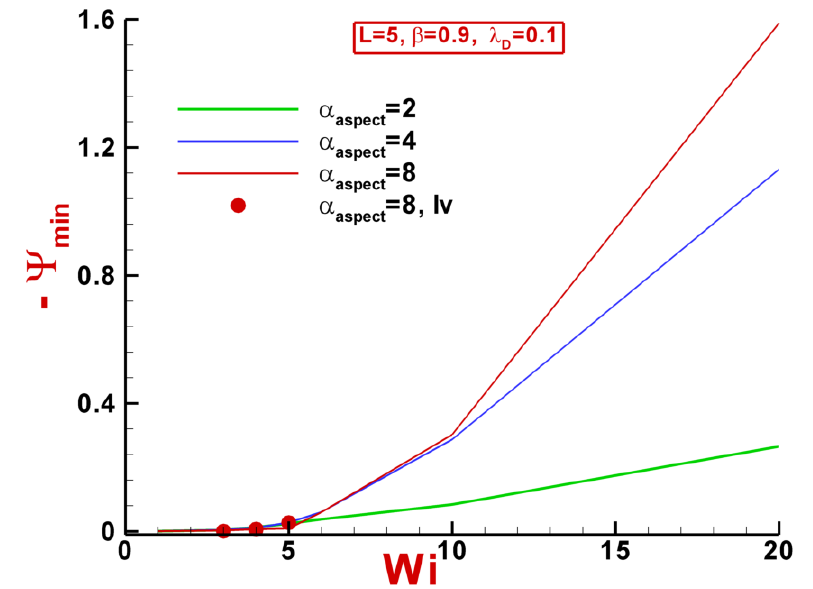
α = {2, 4, 8}; swIM [ L = 5, β ≤ 0.9]; λ aspect min ) against Wi ;